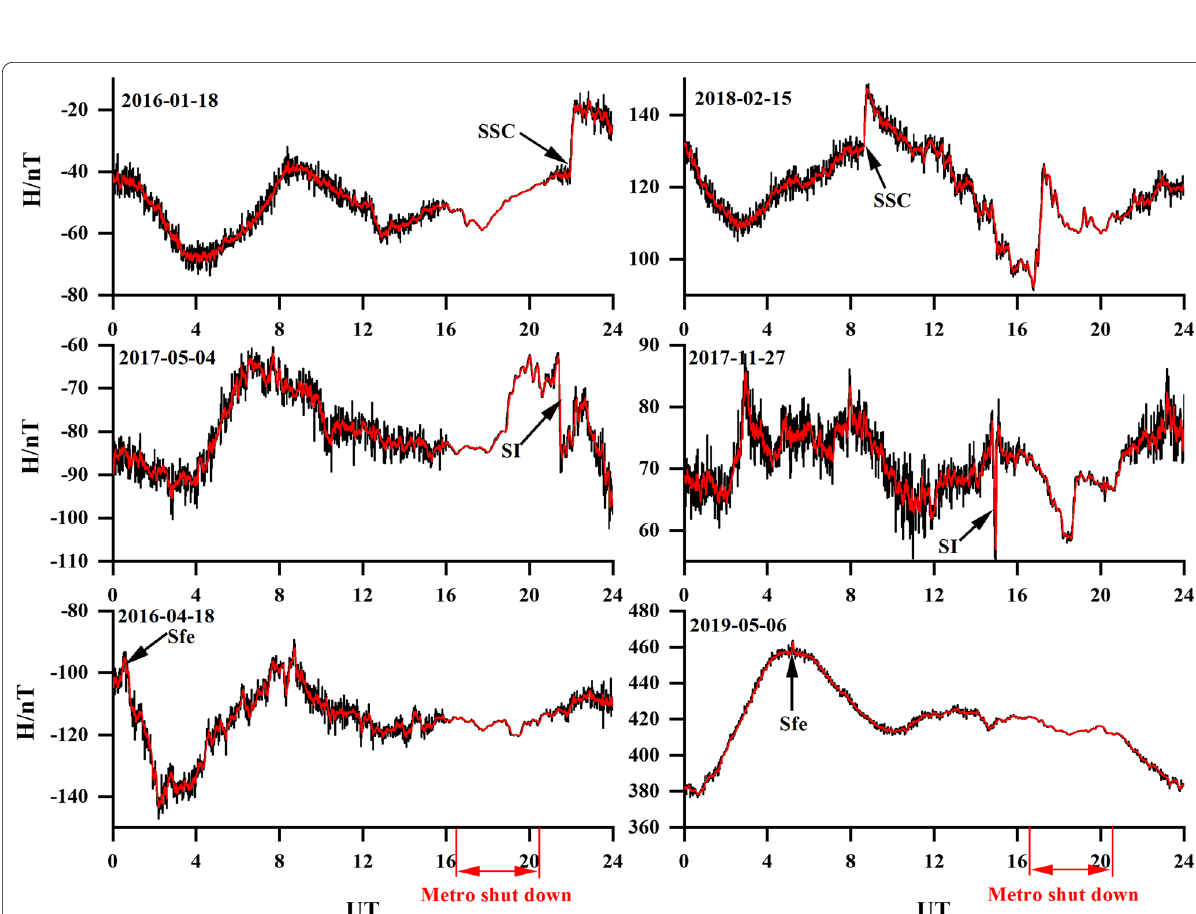
Fig. 7 Horizontal component of the geomagnetic data containing rapid variations. Black and red lines represent the raw data and the processed data with the adaptive Kalman filter,